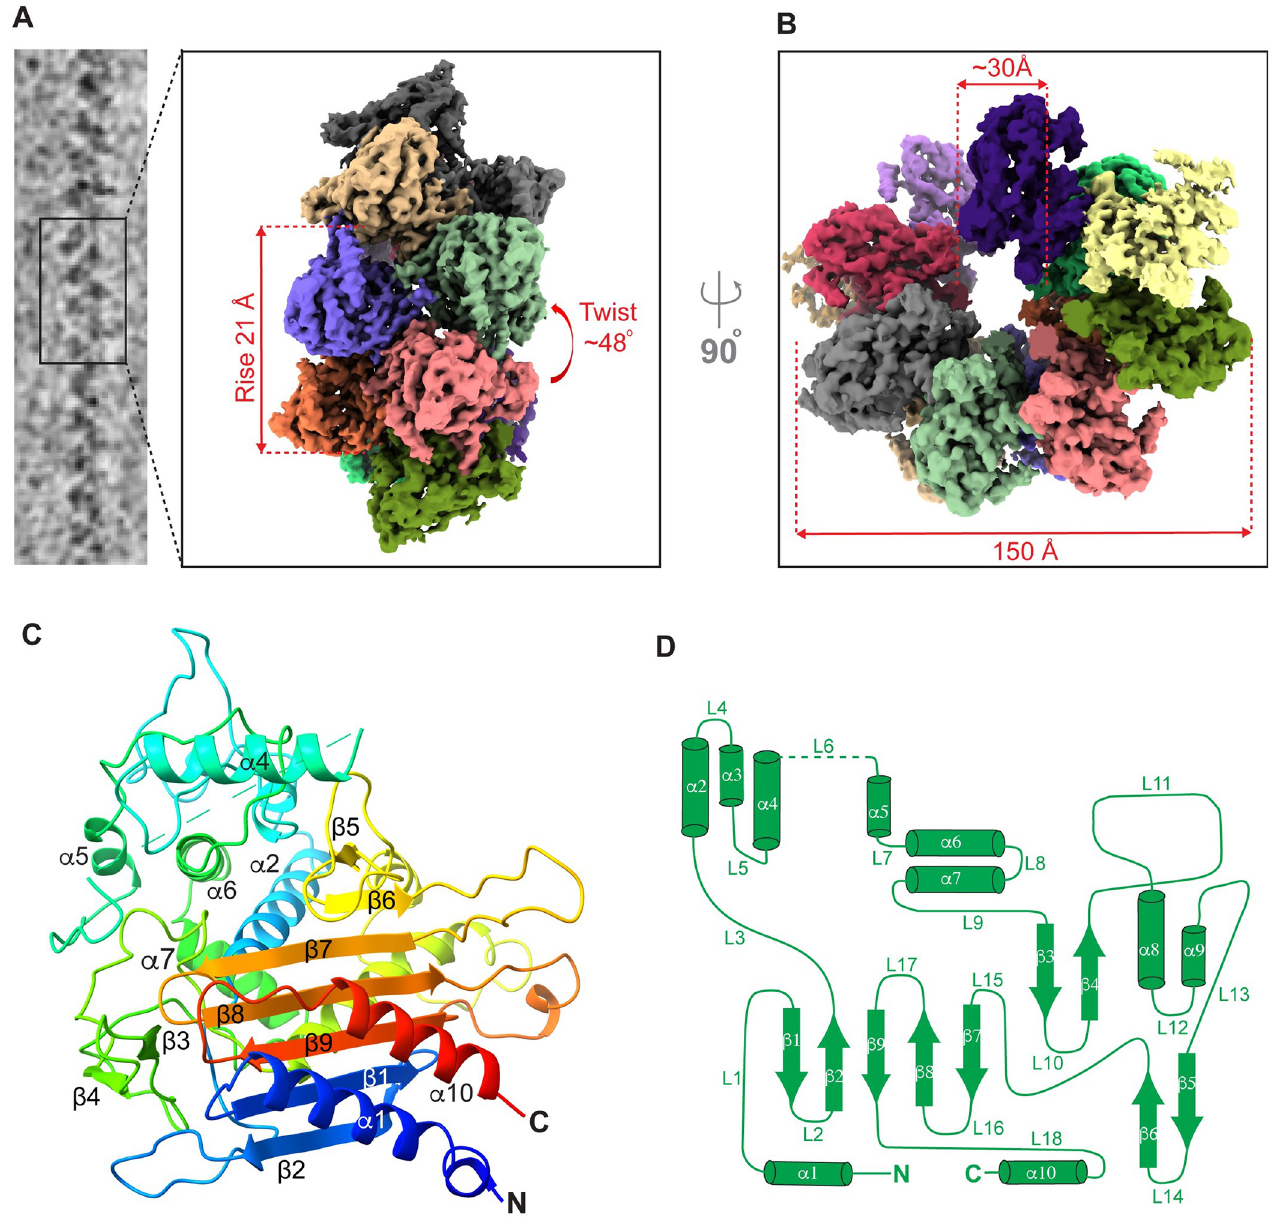
Fig 2. CryoEM structure of human LACTB filament. ( A ) CryoEM images of helical LACTB filaments were processed to obtain the 3D reconstruction of the polymer. LACTB protomers are colored differently, and filament rise and twist are indicated. ( B ) Top view of the LACTB assembly with the indicated filament width and inner lumen diameter. ( C ) Ribbon diagram of LACTB monomer. The chain is colored in a rainbow gradient from N-terminus (blue) to C-terminus (red). Secondary structure elements of one protomer are labeled. ( D ) LACTB (residues 97 to 547) α -helices (cylinders), β -sheets (arrows), and loops (lines) are depicted in a topology